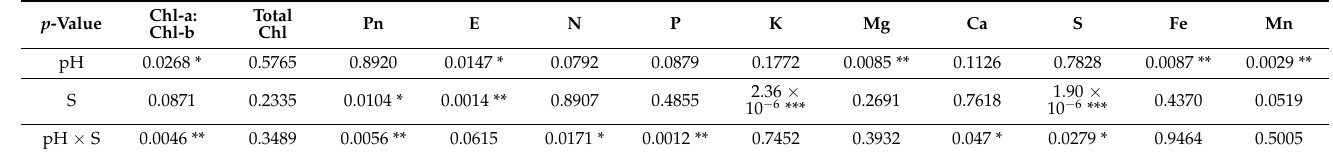
Table 1. ANOVA table showing p -values of the effects of pH and S treatments on the parameters measured in Saskatoon berry ( n = 6).